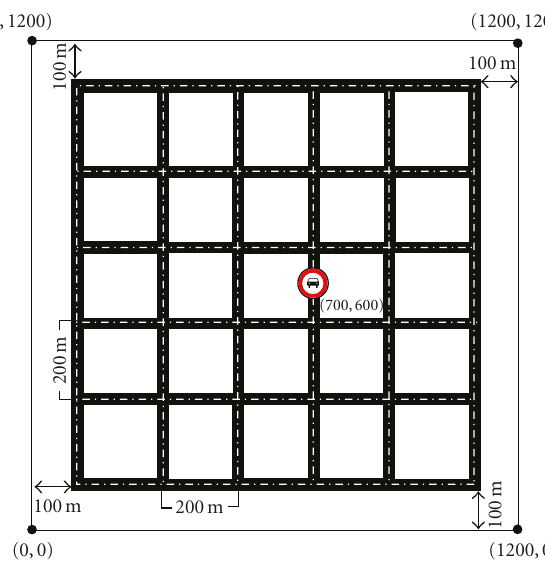
Figure 3: The street map used in our simulations. The location coordinate of the marked tra ffi c event is at (700,